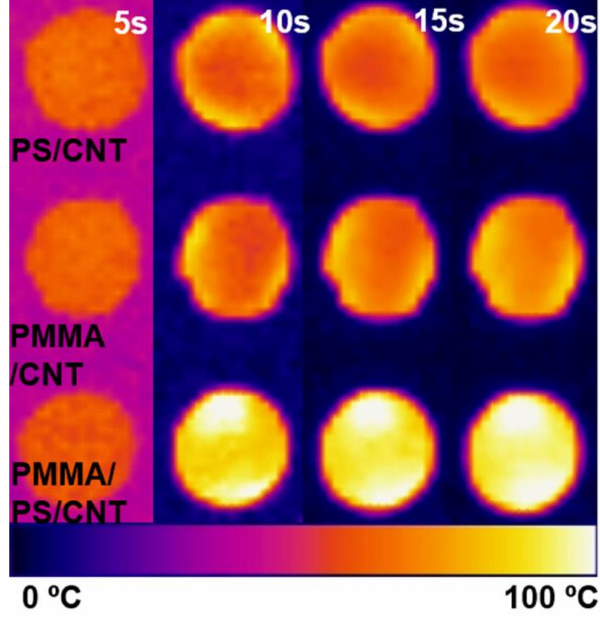
Figure 11. IR image of samples that represent the e ff ect of double